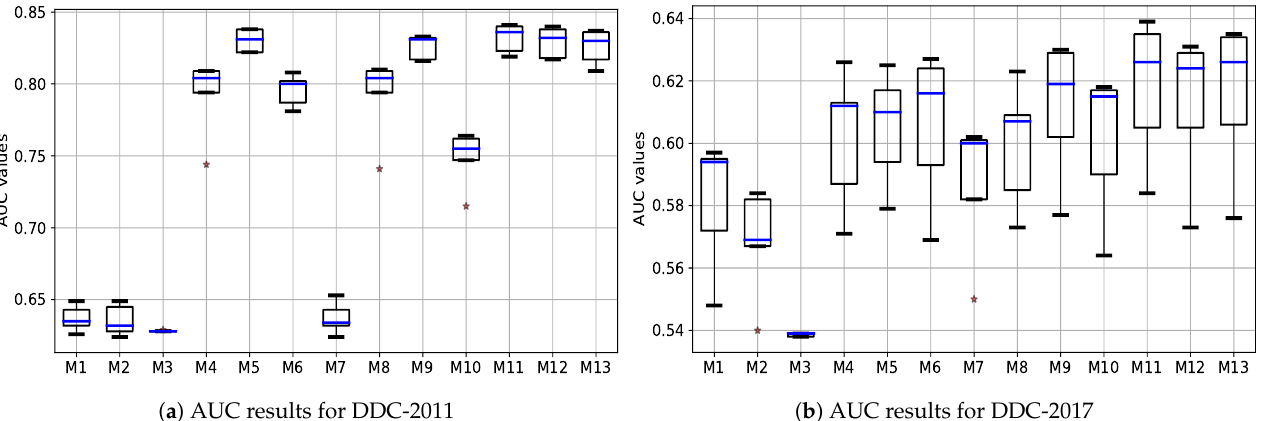
Figure 3. Box and whisker plots of AUC results acquired from 5-fold cross-validation on various ML classifiers, where M-1 to M-13 represent GNB, BNB, RF, DT, XGB, LGB, GNB + BNB, RF + DT, LGB + XGB, GNB + BNB + DT + RF, GNB + BNB + XGB + LGB, DT + RF + LGB + XGB, and GNB + BNB + DT + RF + XGB + LGB,